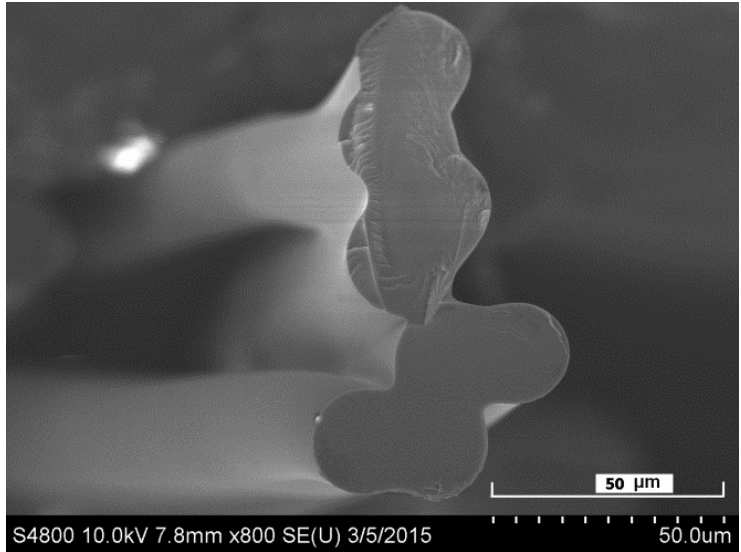
Figure 3. SEM image of Ace-SKL control fibers (without prior UV treatment) heated rapidly at 1.2 °C/min that led to multiple fibers fusing together.